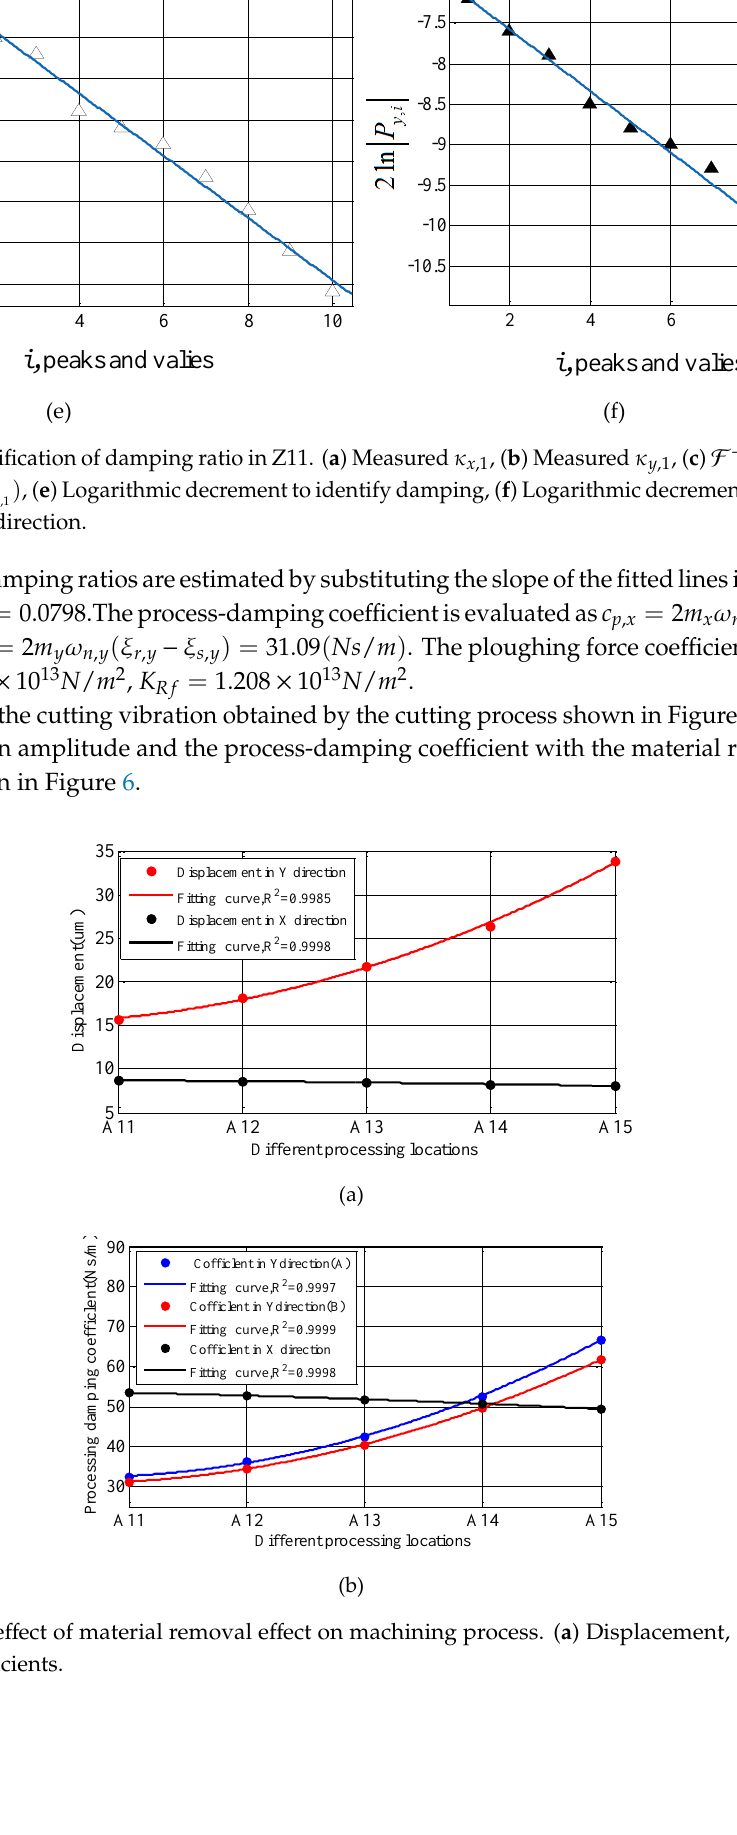
Figure 6. The e ff ect of material removal e ff ect on machining process. ( a ) Displacement, ( b ) Process- damping coe ffi